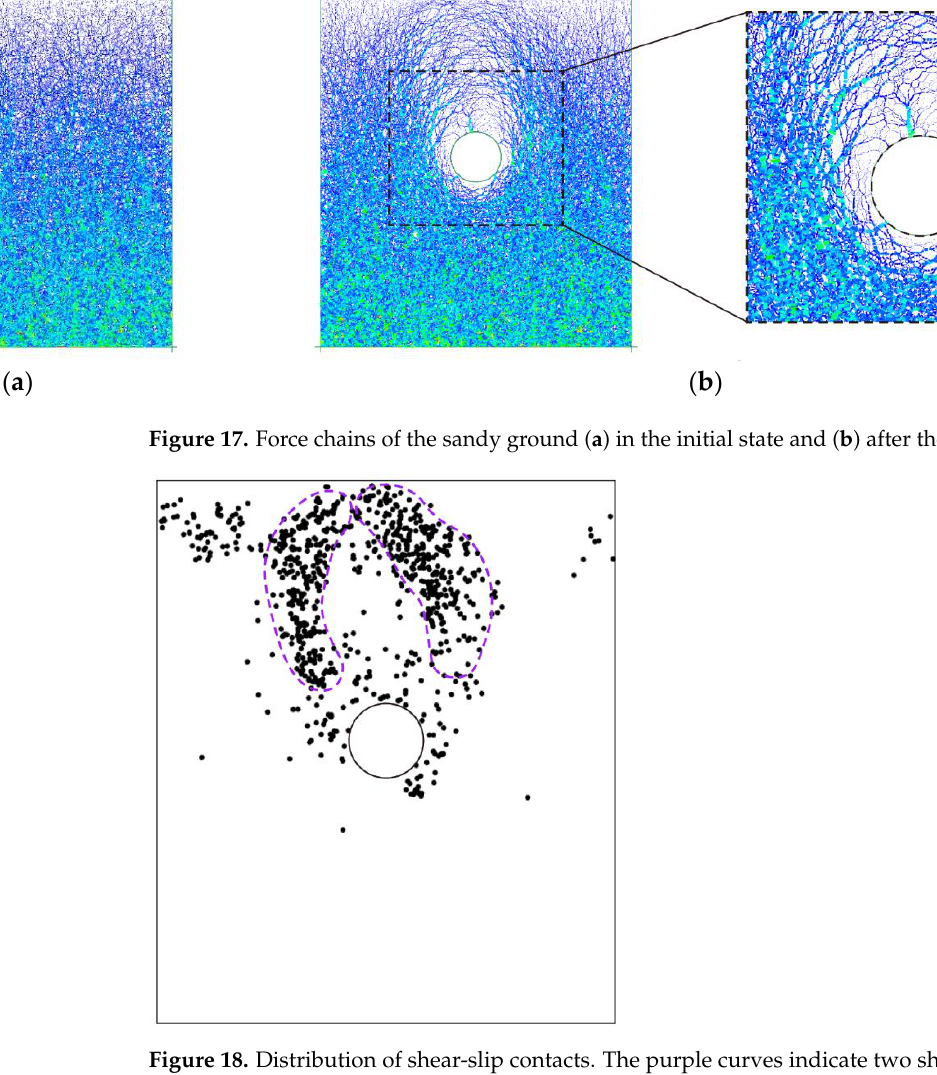
Figure 18. Distribution of shear-slip contacts. The purple curves indicate two shear bands.